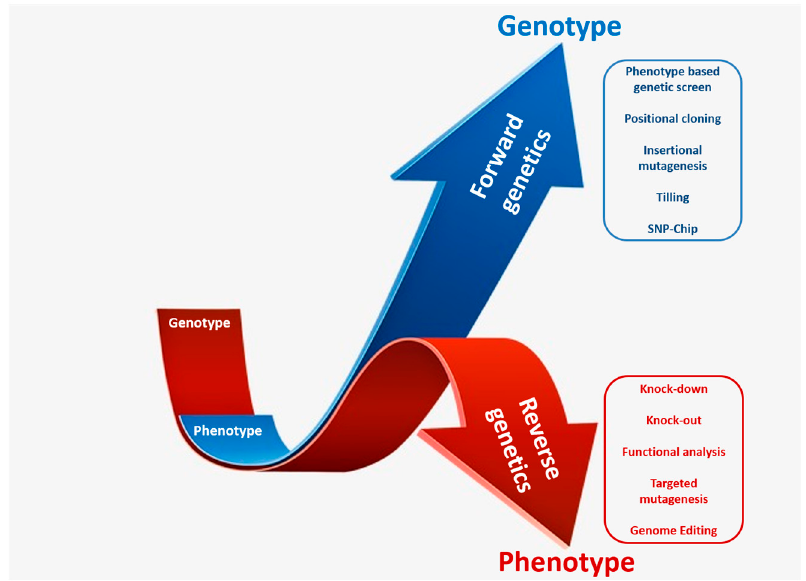
Figure 2. A schematic representation of forward and reverse genetic approaches for identification and characterization of candidate genes. Forward genetics studies start with the selection of the desired phenotype and culminate with the identification of the responsible gene responsible (depicted in blue arrow). Reverse genetics studies start with the selection of gene of interest and end with the analysis of resulting phenotype (depicted in red arrow).